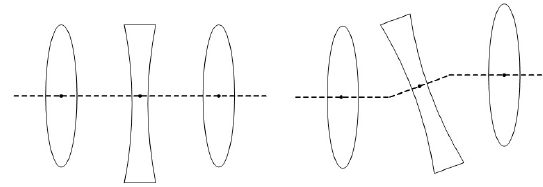
Figure 7: the optical center of lens is not rigorous collinear